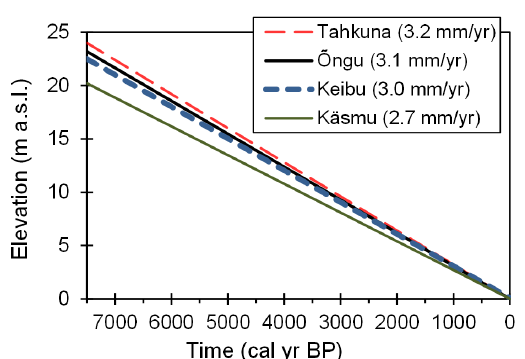
Fig. 3. Simplified apparent water level curves as a result of postglacial uplift and water volume change over the last 7500 years in the regions of the Tahkuna Peninsula and Õngu (according to Vassiljev et al. 2015), and Keibu Bay and Käsmu (according to Grudzinska et al. 2013). Over the last 100 − 150 years an accelerating modern-era global sea level rise has introduced a ~30 cm bend in the curve (which is barely visible). Also, according to e.g. Lambeck et al (2014), the eustatic sea level rise has not been linear over the late Holocene; the rise rate probably was approximately 0.2 mm/yr in 0–4200 cal yr BP, but slightly faster earlier.